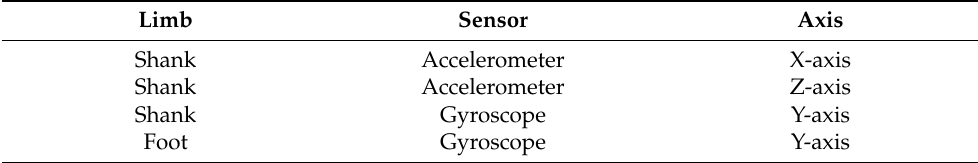
Table 1. Left Limb Kinematic